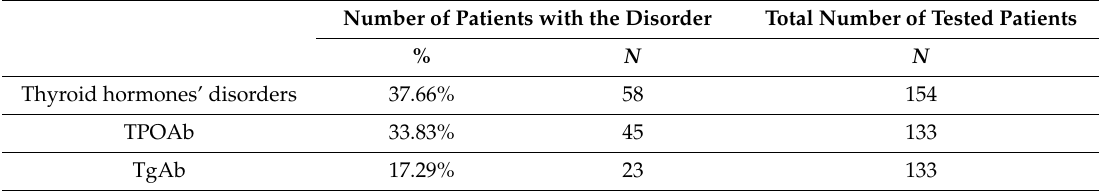
Table 3. Frequency of developing thyroid function disorders after HSCT in the analyzed group.